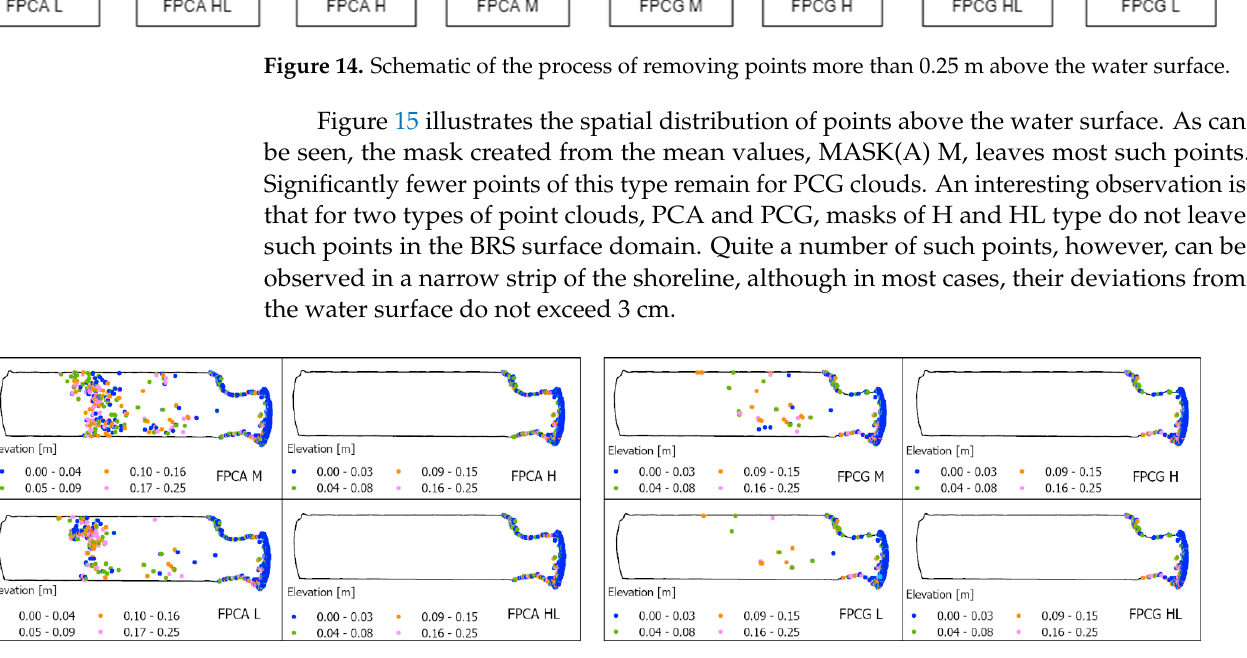
Figure 14. Schematic of the process of removing points more than 0.25 m above the water surface.